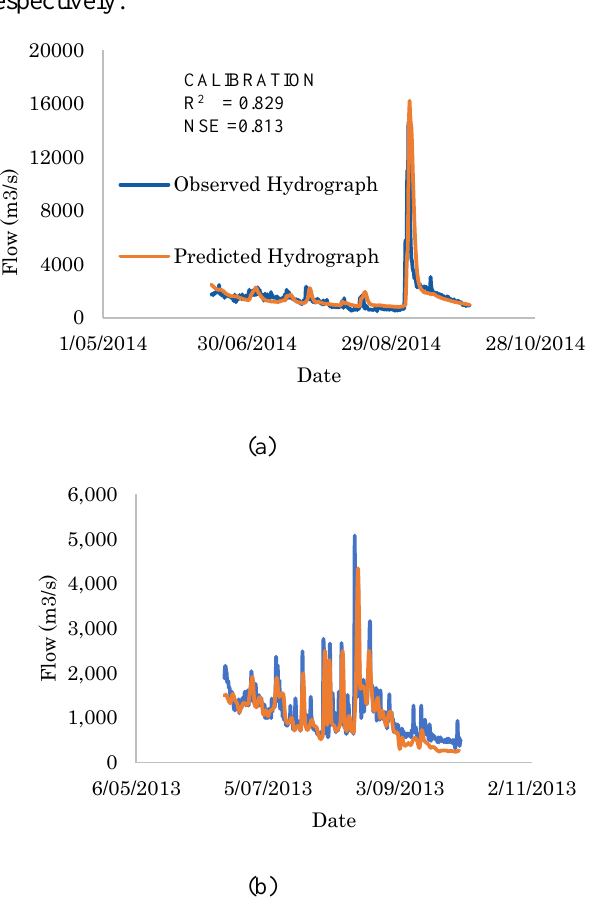
Fig. 13. (a) Calibration (for year 2014) and (b) validation (for year 2013) results in Mangla dam